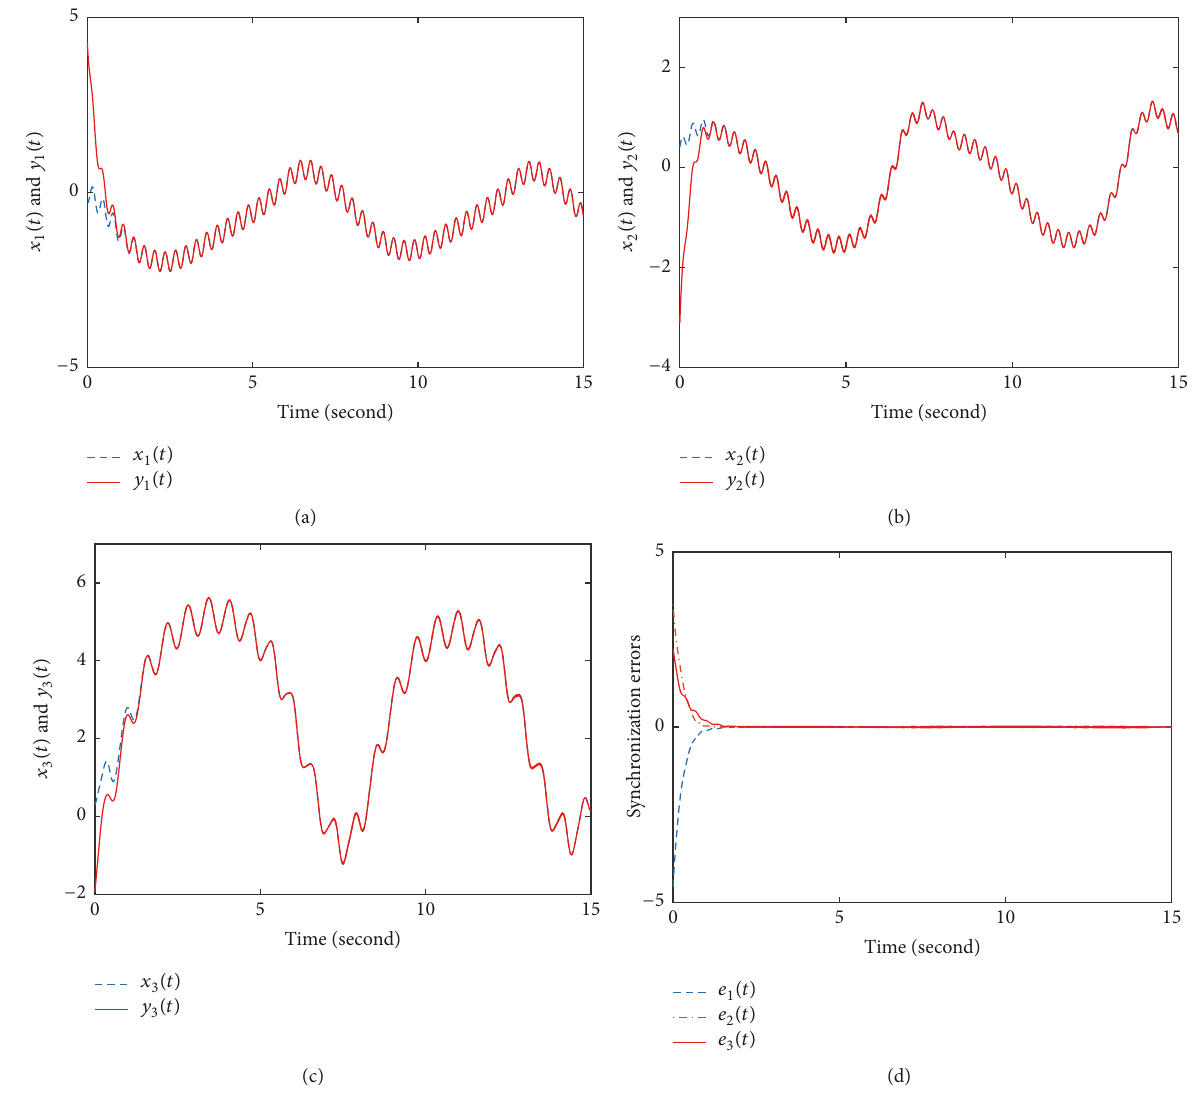
Figure 8: Simulation results when 𝜉(𝑡) = −[2 sin (10𝑡) + 15 rand (𝑡);2 cos (10𝑡) + 20 rand (𝑡);2 sin (5𝑡) + 18 rand (𝑡)] 𝑇 in (a) 𝑥 1 (𝑡) and 𝑦 1 (𝑡) ; (b) 𝑥 (𝑡) and 𝑦 (𝑡) ; (c) 𝑥 (𝑡) and 𝑦 (𝑡) ; (d) synchronization 2 2 3 3